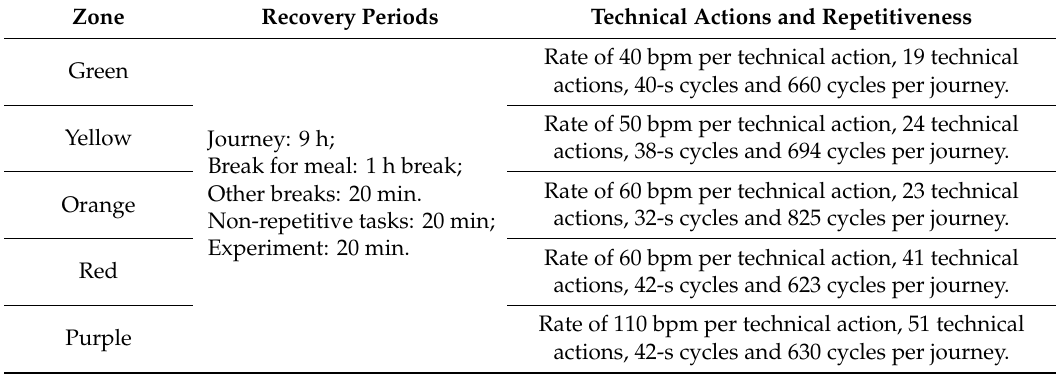
Table 3. Repetitive task parameters designed for this study according to OCRA Index risk levels: Recovery Periods, Technical Actions, and Repetitiveness.